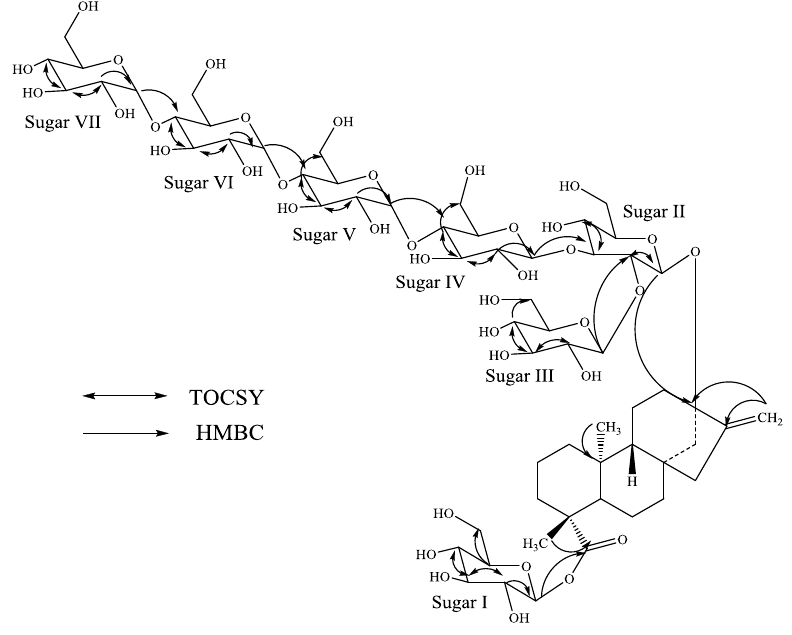
Figure 4. Key COSY and HMBC correlations of 3 .